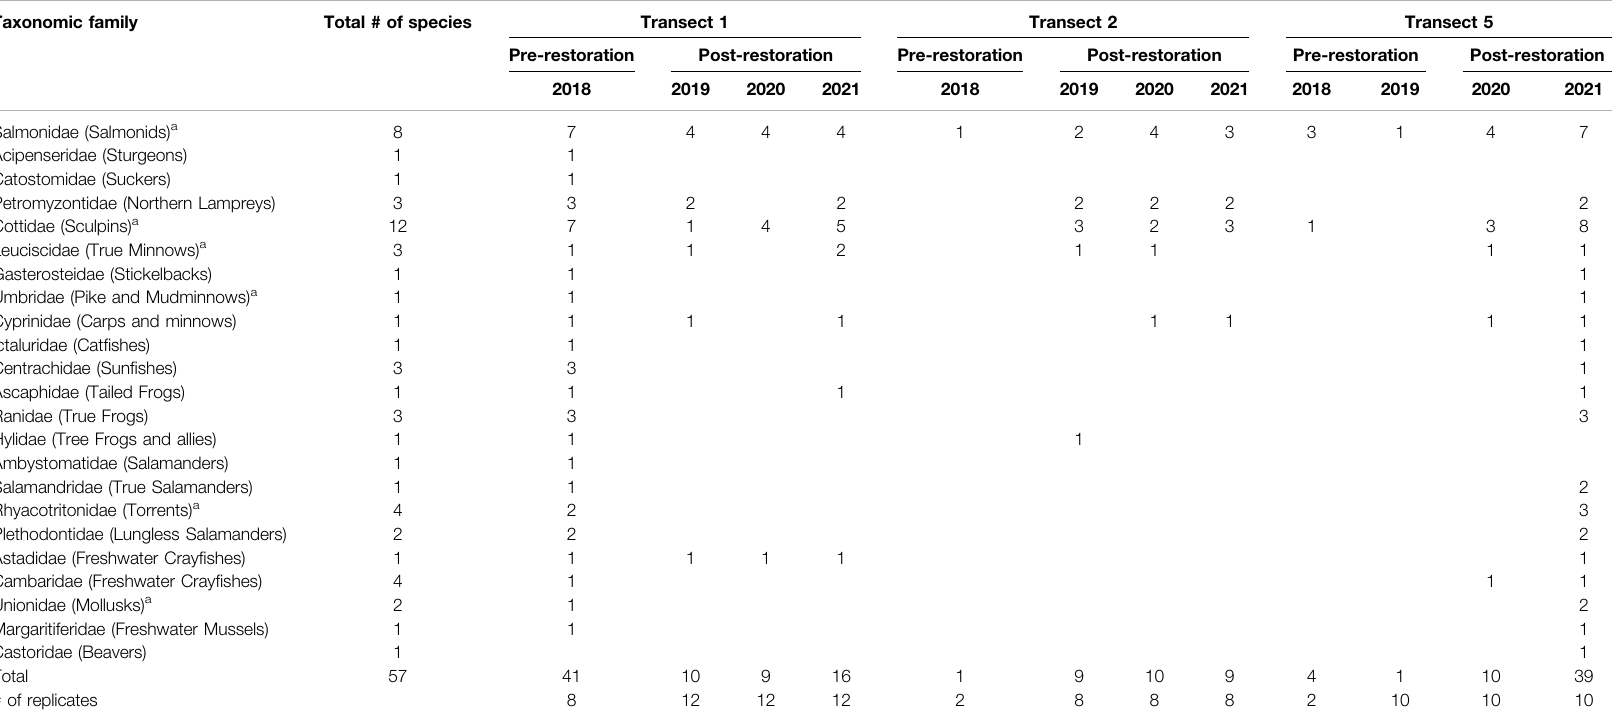
TABLE 2 | Aquatic Biodiversity richness from eDNA metabarcoding of species detections grouped within their taxonomic family during spring at three transects that underwent restoration activities at the South Fork McKenzie River. Post-restoration started spring of 2019 at Transects 1 and 2 and in spring of 2020 at Transect 5 (grayed cells). Duplicate samples were analyzed from each strata along a transect for each time period and pooled within their respective transect/time period.